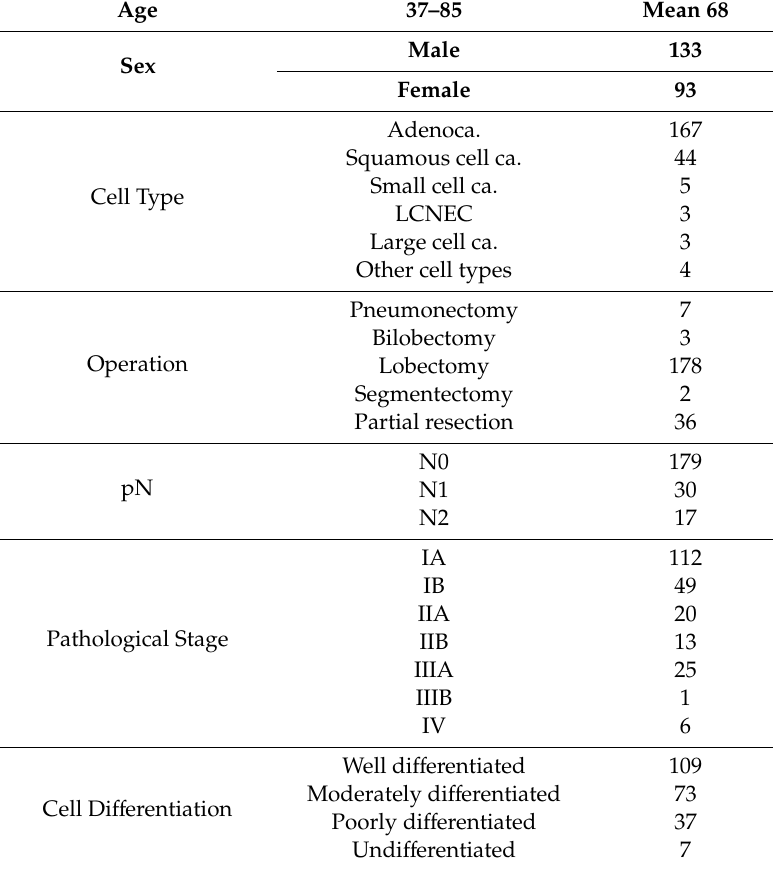
Table 2. Patients’